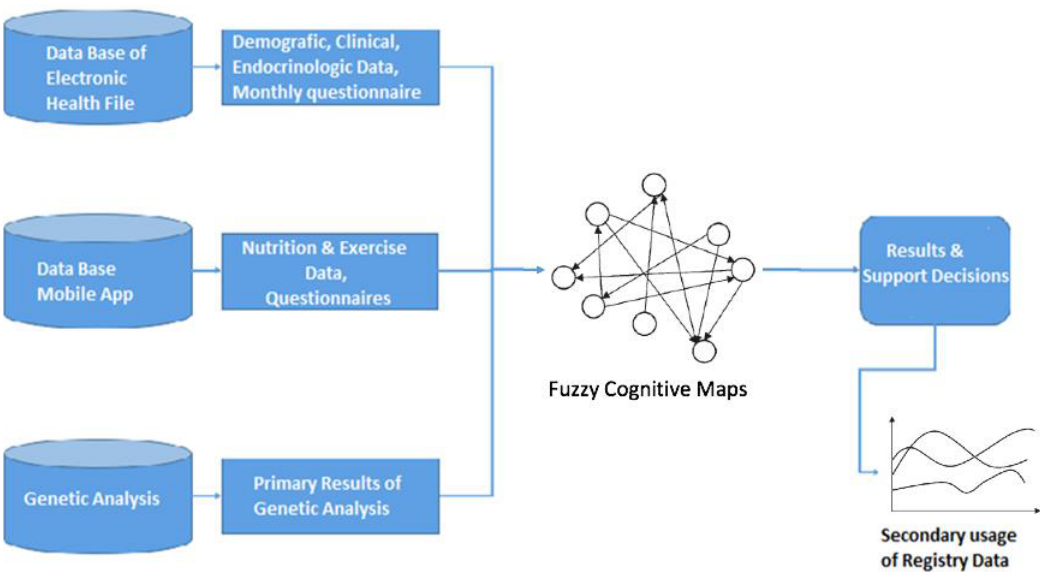
Figure 1. Pedobesity—Development of Intelligent Multi-level Information Systems and Specialized Artificial Intelligence Algorithms for Personalized Management of Obesity in Childhood and Adolescence: The Main Innovative Actions.